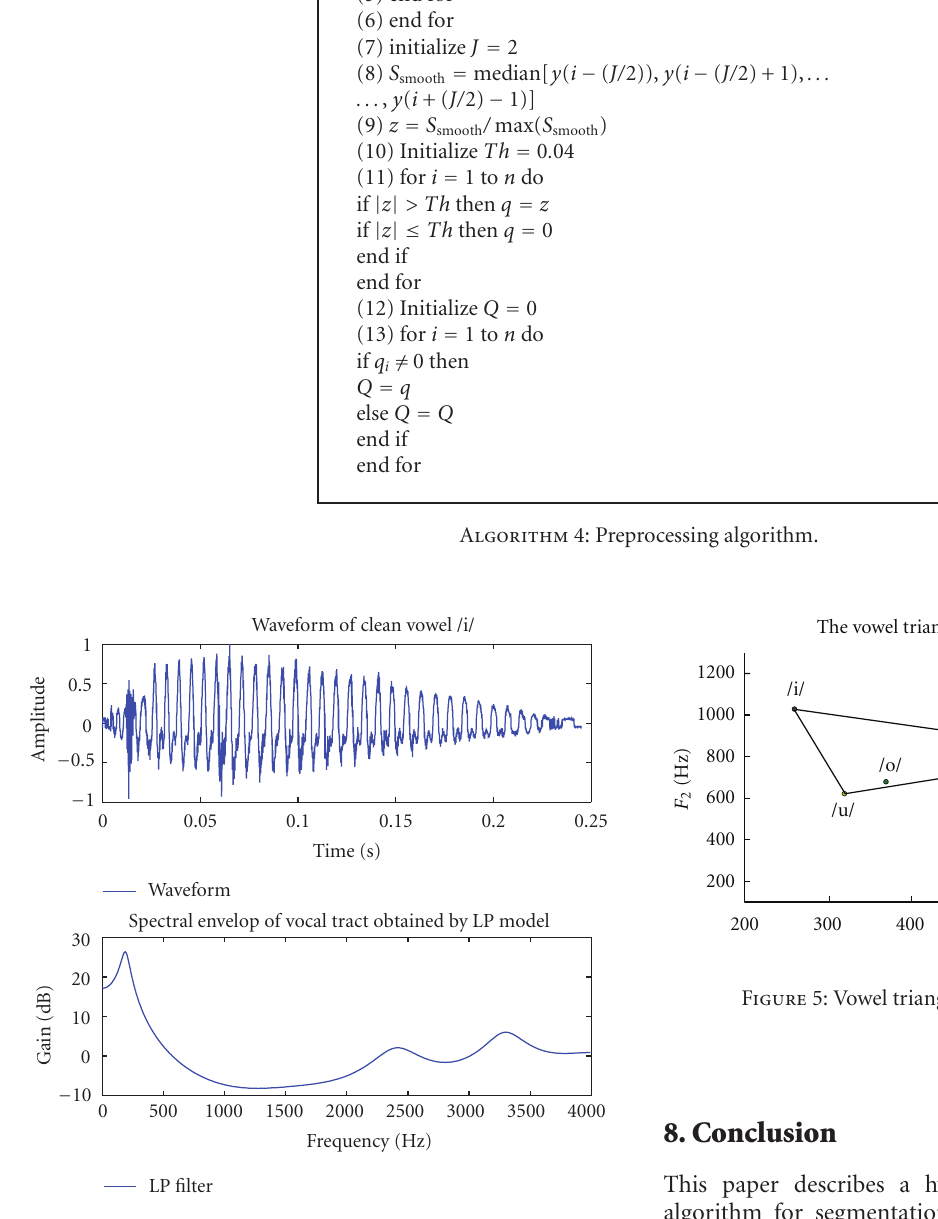
Figure 4: Spectral envelop of vocal tract for the phoneme /i/.